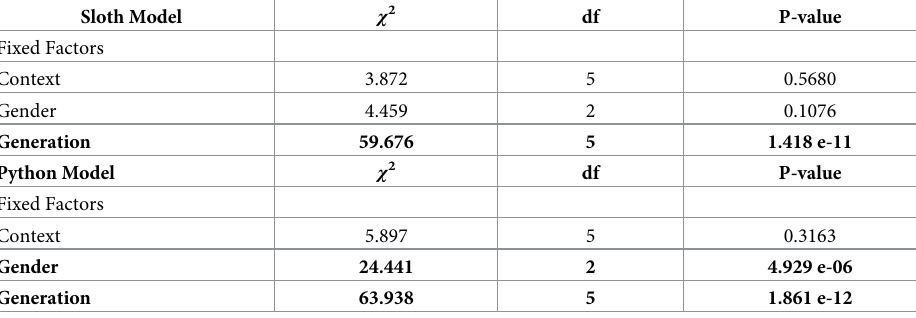
Table 2. Likelihood ratio test results for ordinal logistic regression models.